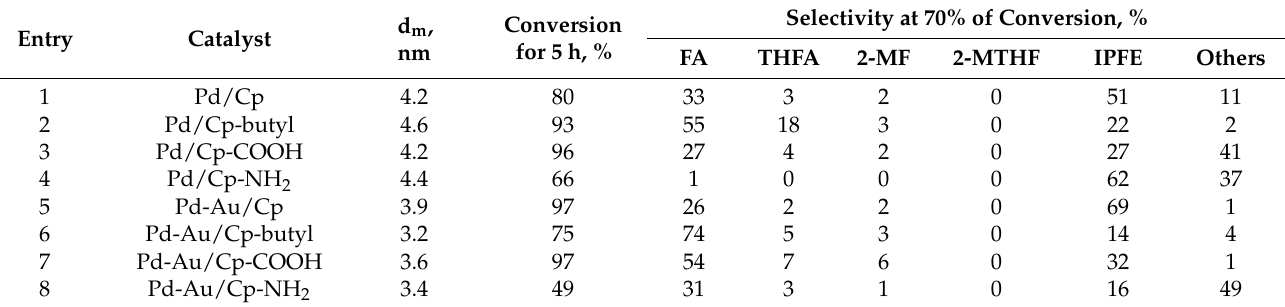
Table 7. Catalytic results of the hydrogenation of